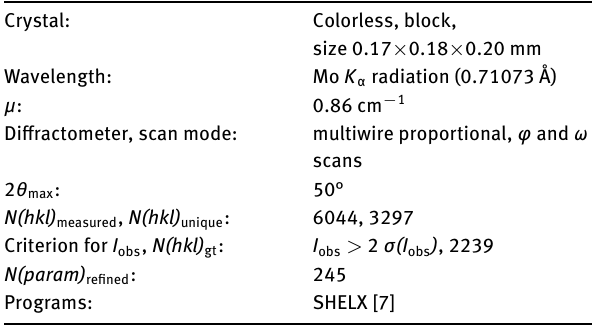
Table 2: Fractional atomic coordinates and isotropic or equivalent isotropic displacement parameters (Å 2